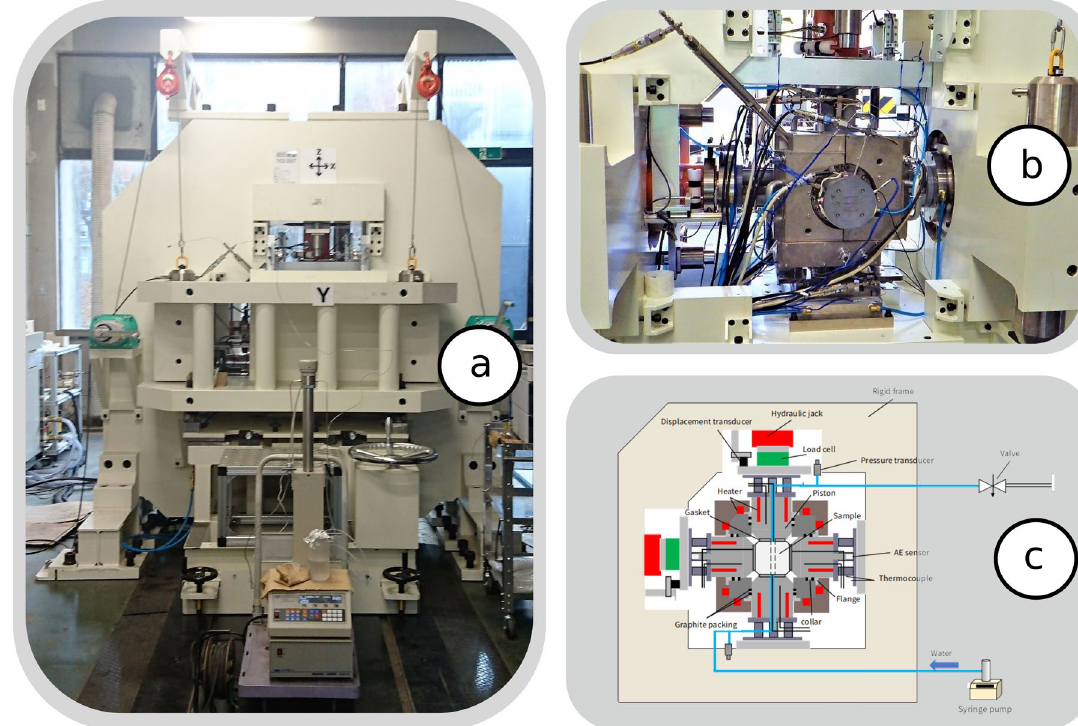
Figure 10. The experimental apparatus is composed of a loading frame ( a ), a true triaxial cell ( b ) and a system of pumps and measuring devices to conduct the experiments at temperatures up to 500 ◦ C ( c